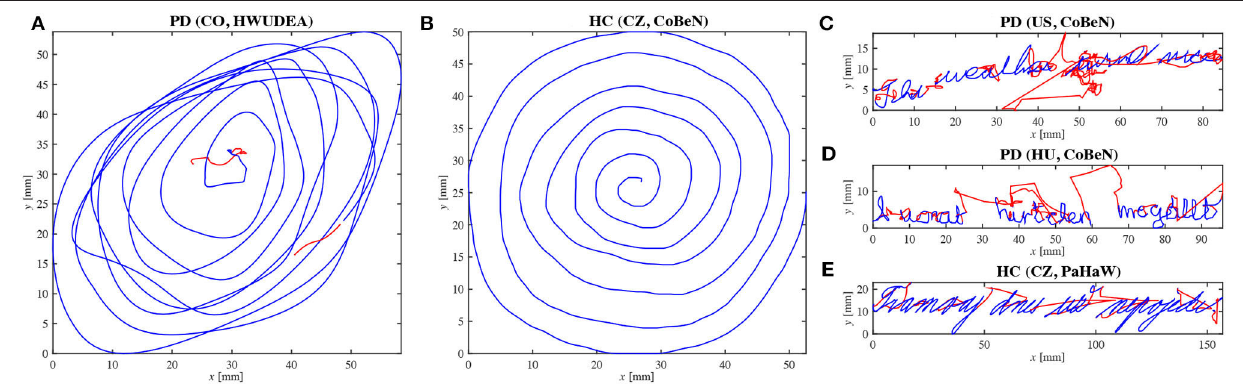
FIGURE 1 | Selected samples from the multilingual dataset (blue line–on-surface movement; red line–in-air movement). (A) Spiral drawing (PD patient); (B) Spiral drawing (HC); (C) English sentence (PD patient) “The weather turned nice”; (D) Hungarian sentence (PD patient) “A vonat hirtelen megállt”; (E) Czech sentence (HC) “Tramvaj dnes už